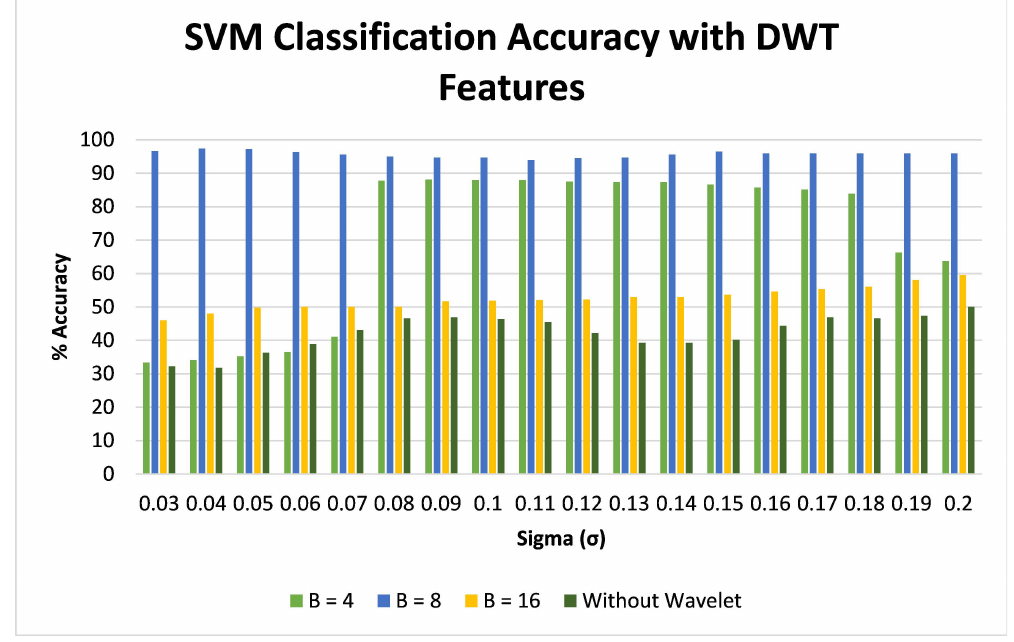
Figure 6. Classification accuracy (%) of SVM classifier with DWT features with different block/window sizes ( B − window is B × B